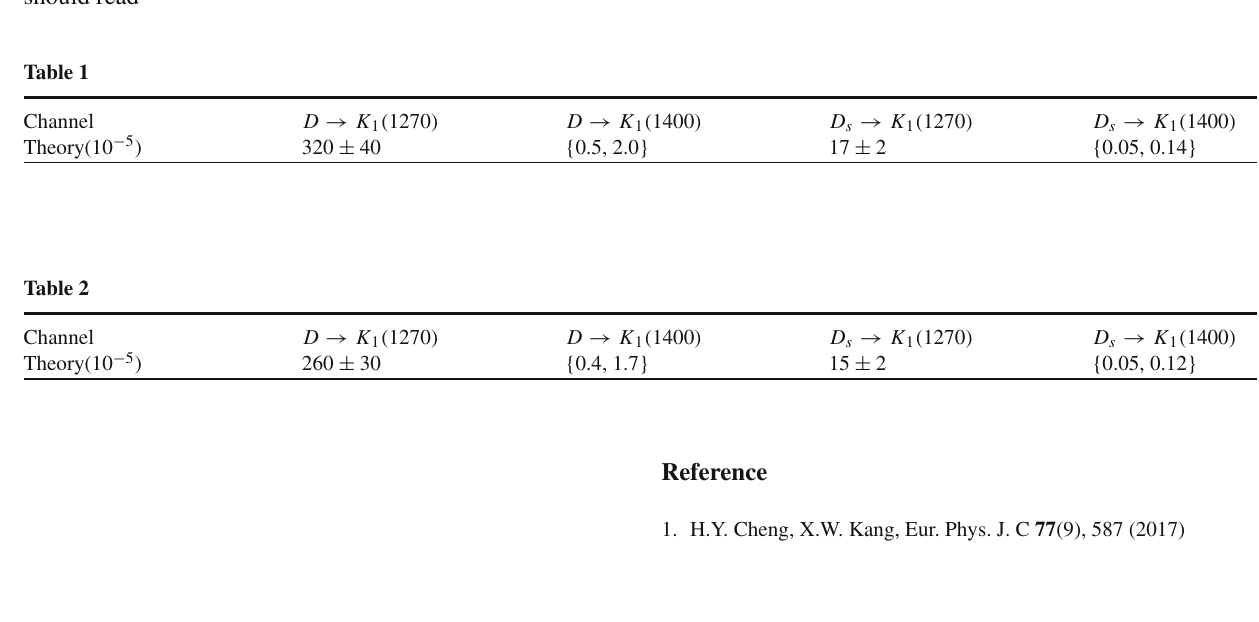
On p. 6, right column, second line from bottom, h 1 ( 1170 ) should be replaced by h 1 ( 1380 )